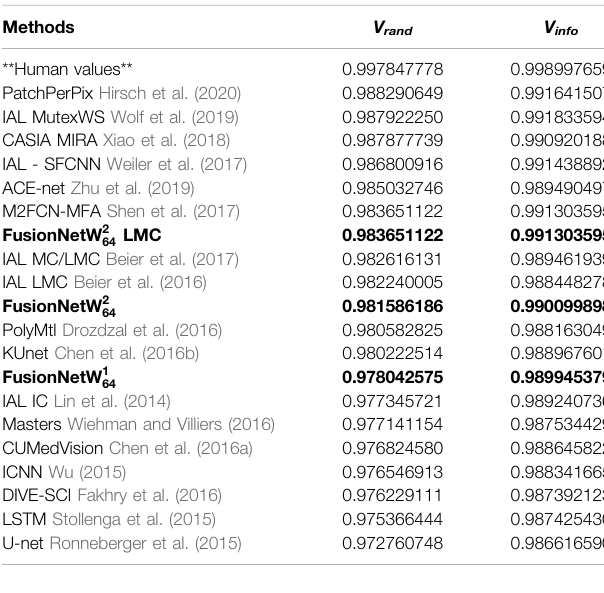
TABLE 2 | Accuracy of various segmentation methods on the Drosophila EM dataset(ISBI2012EMsegmentationchallengeleaderboard,June2020).Bold values correspond to the method presented